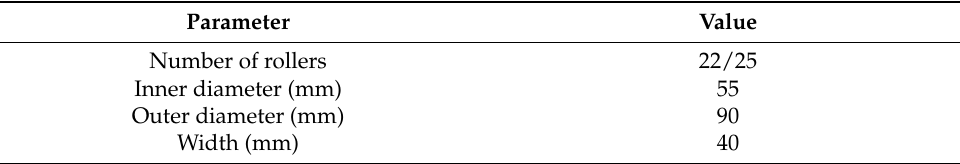
Table 2. Fundamental parameters of double row conical roller